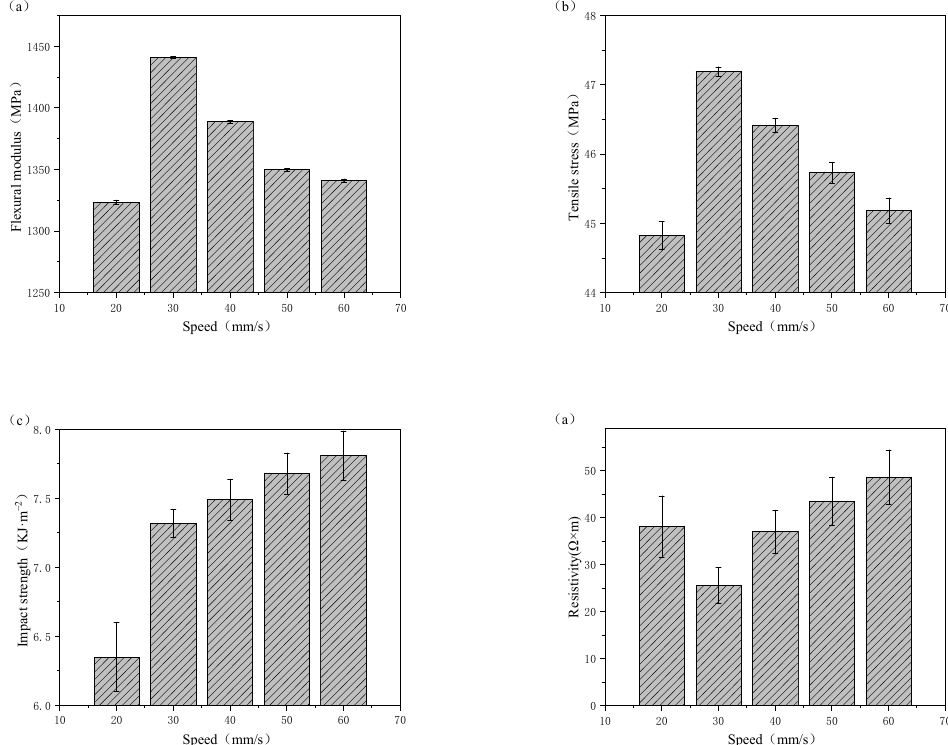
Figure 7. Effect of printing speed on the ( a ) flexural modulus, ( b ) tensile strength, ( c ) impact strength, and ( d ) volume resistivity of printed samples.